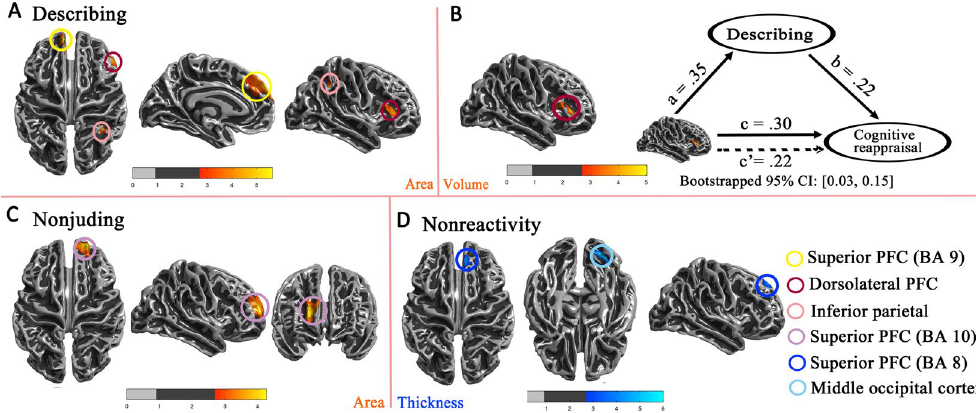
Figure 3. Cortical thickness, volume and surface area were correlated with the FFMQ. ( A ) The surface areas of the superior PFC (BA 9), the dorsolateral PFC (BA46) and the inferior parietal lobule exhibited significant positive correlations with the Describing facet. ( B ) The cortical volume of the dorsolateral PFC (BA 46) was positively correlated with the Describing facet, and the Describing mediated the association between the dorsolateral PFC and cognitive reappraisal. ( C ) The surface area of the superior PFC (BA 10) was significantly correlated with the Nonjuding facet. ( D ) Superior PFC (BA 8) thickness exhibited significant negative correlation with the Non reactivity